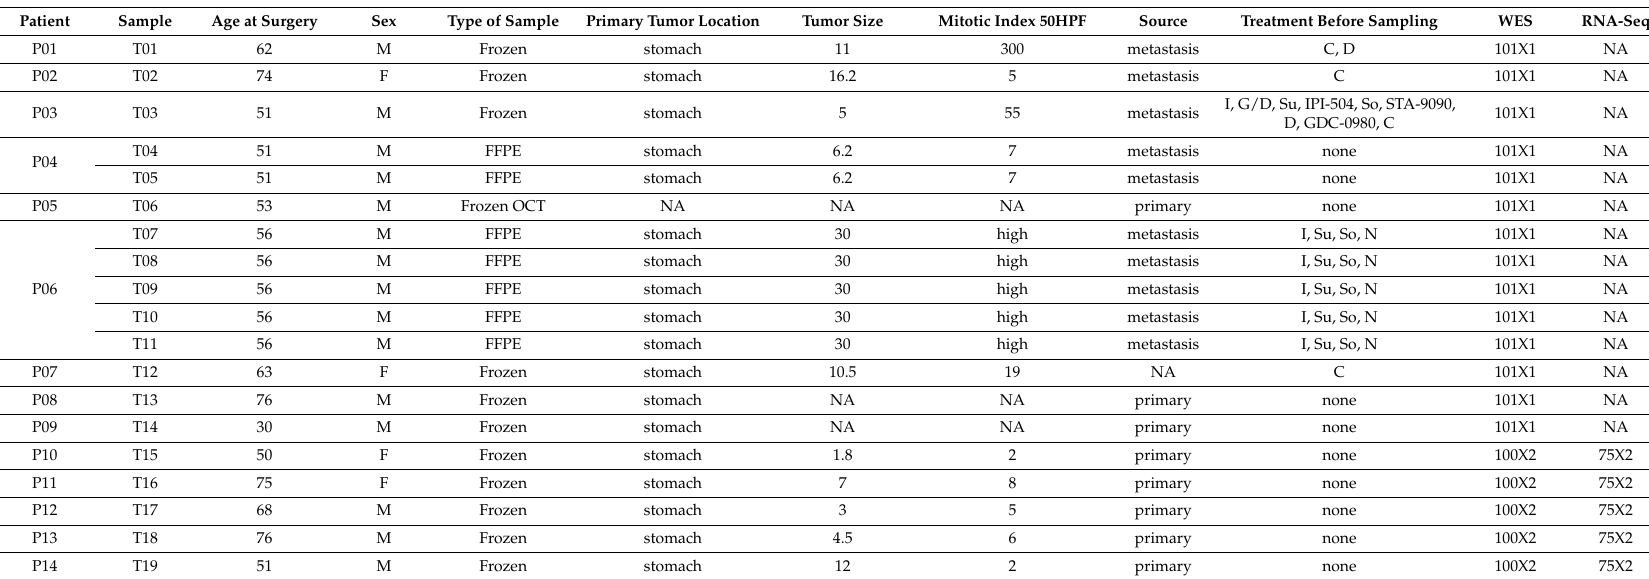
Table 1. Patients and Tumor